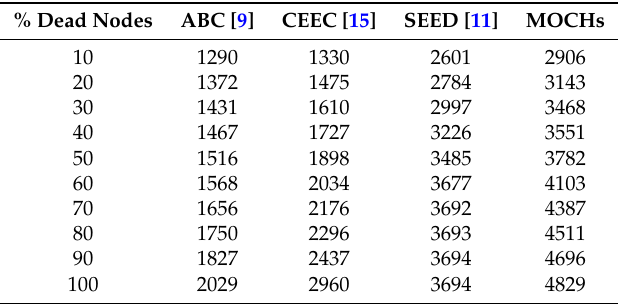
Table 5. Round history of dead nodes over simulations of five WSNs (with 300 nodes).